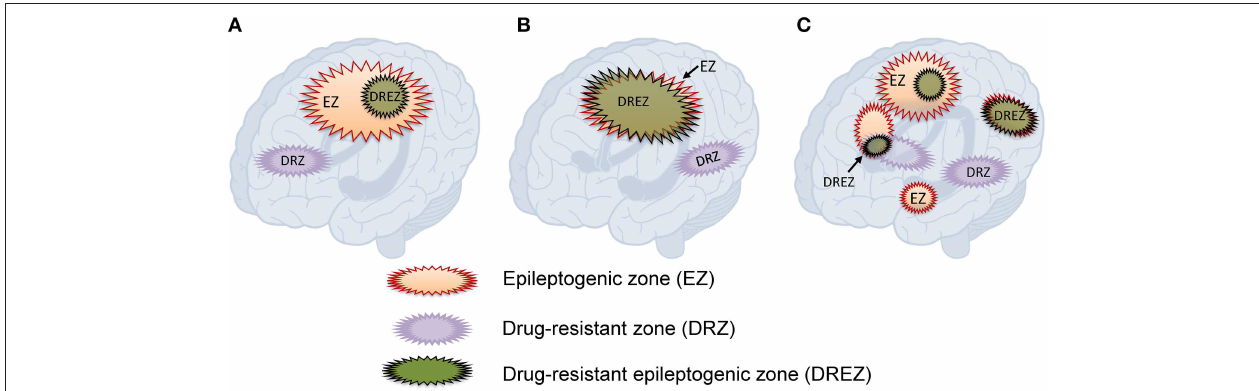
FIGURE 1 | Hypothesized relationships between the drug-resistant epileptogenic zone and epileptogenic zone. (A) The drug-resistant epileptogenic zone is part of the epileptogenic zone. (B) The drug-resistant epileptogenic zone overlaps with the whole epileptogenic zone. (C) In multifocal epilepsy, the drug-resistant epileptogenic zone overlaps with some of the epileptogenic foci. Drug-resistant zone and epileptogenic zone may exclude from each